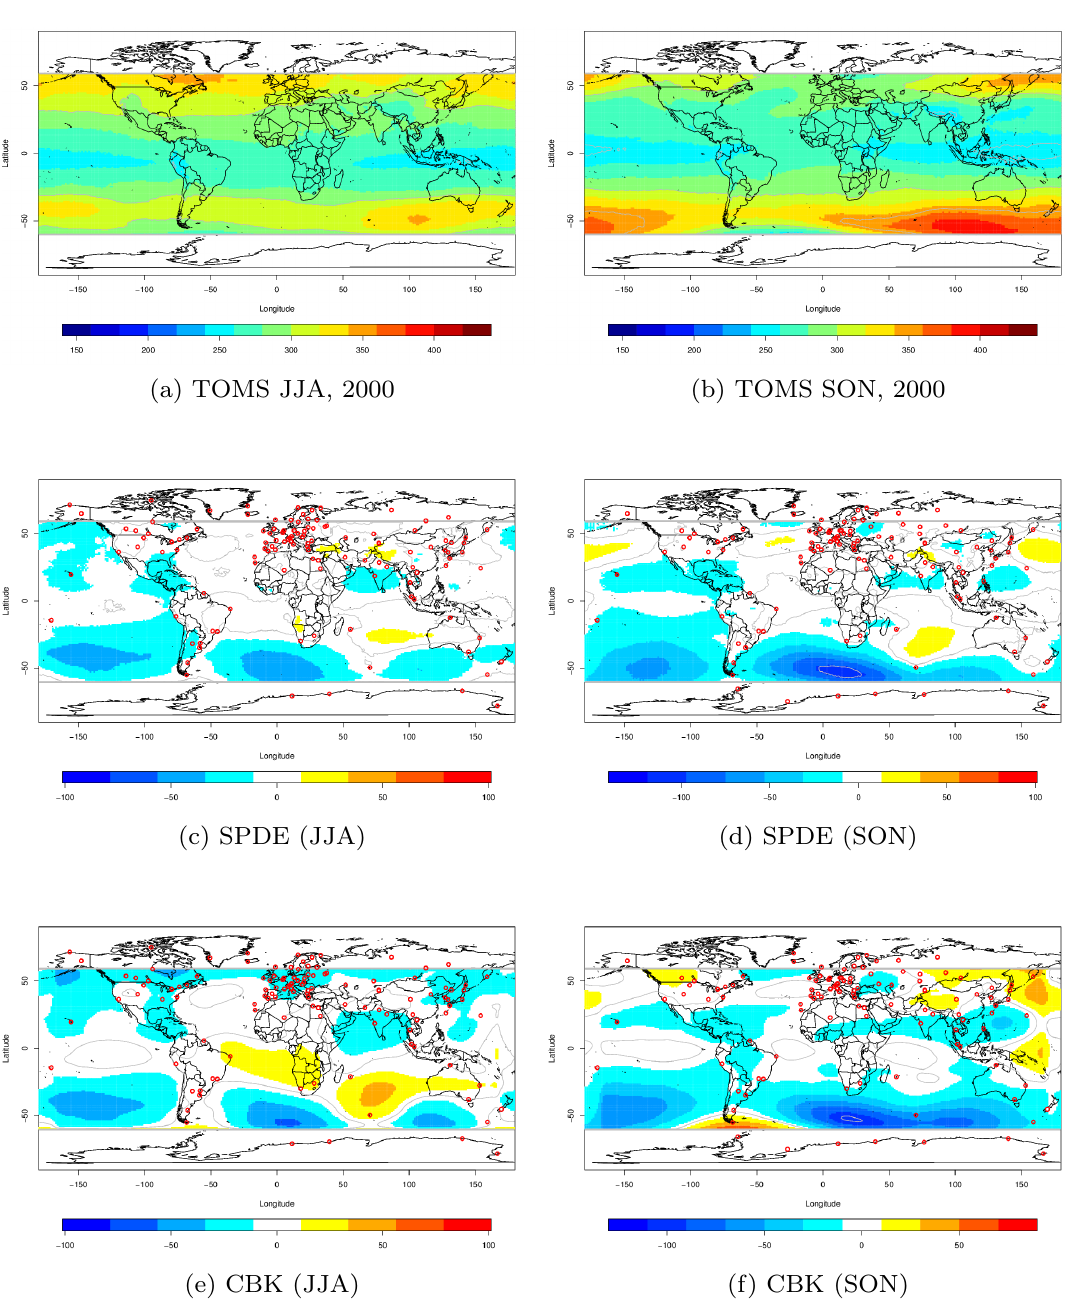
Figure 7. Ozone mapping from TOMS data in (a) JJA and (b) SON; global difference mapping of SPDE and covariance-based kriging (CBK) predicted mean with respect to TOMS data in JJA ( c and e ) and SON ( d and f ) 2000.